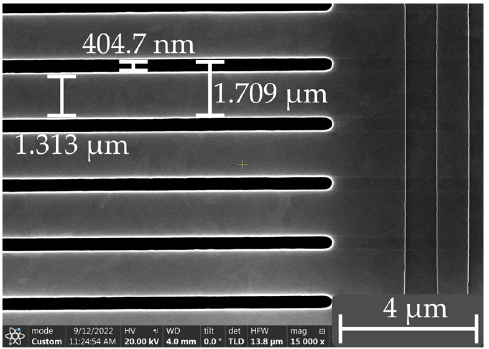
Figure 2. Top view of SEM image of fabricated waveguide structure D.